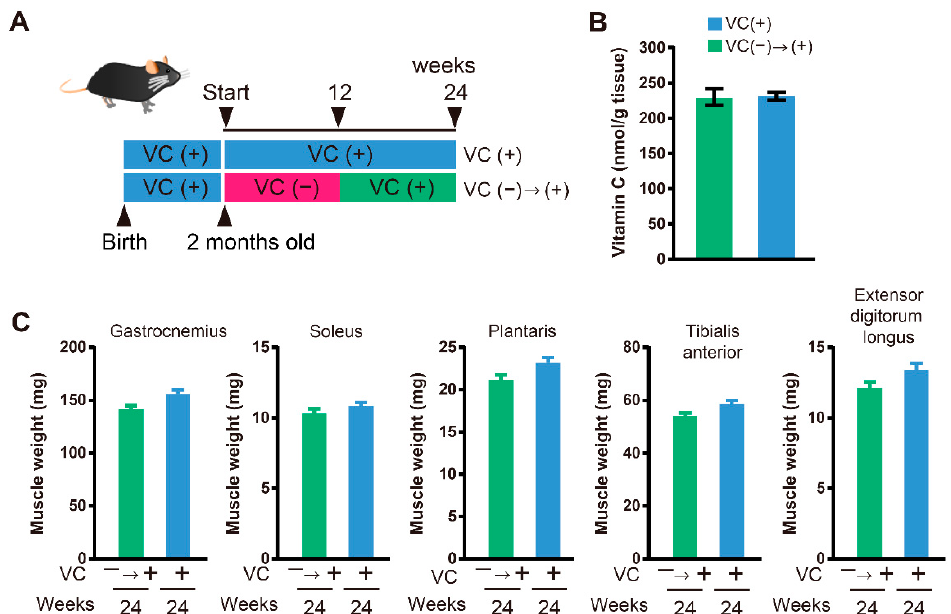
Figure 4. VC supplementation reversed muscle atrophy. ( A ) Experimental procedure. Mice drank 1.5 g/L VC in water until two months of age. Then, mice were divided into two groups: VC-treated (VC(+)) group and VC-untreated (VC( − )) group. VC( − ) mice drank water without VC for twelve weeks and then drank 1.5 g/L VC for twelve weeks (VC( − ) → (+)).VC(+) mice drank 1.5 g/L VC for twenty-four weeks. ( B ) VC levels in the gastrocnemius muscles at twenty-four weeks. n = 8 mice in the VC(+) group and n = 10 mice in the VC( − ) → (+) group. ( C ) Skeletal muscle weights at twenty-four weeks. n = 8 mice in the VC(+) group and n = 10 mice in the VC( − ) → (+) group. Values are given as the mean ± SEM. Statistical differences were considered significant at p < 0.05 between VC(+) and VC( − ) groups.